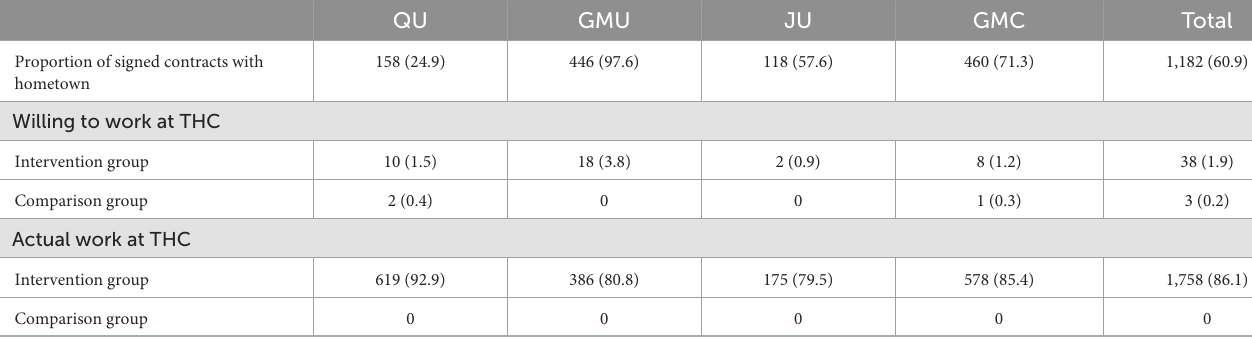
TABLE 4 Percentage of the graduates’ willingness to work and actual work at